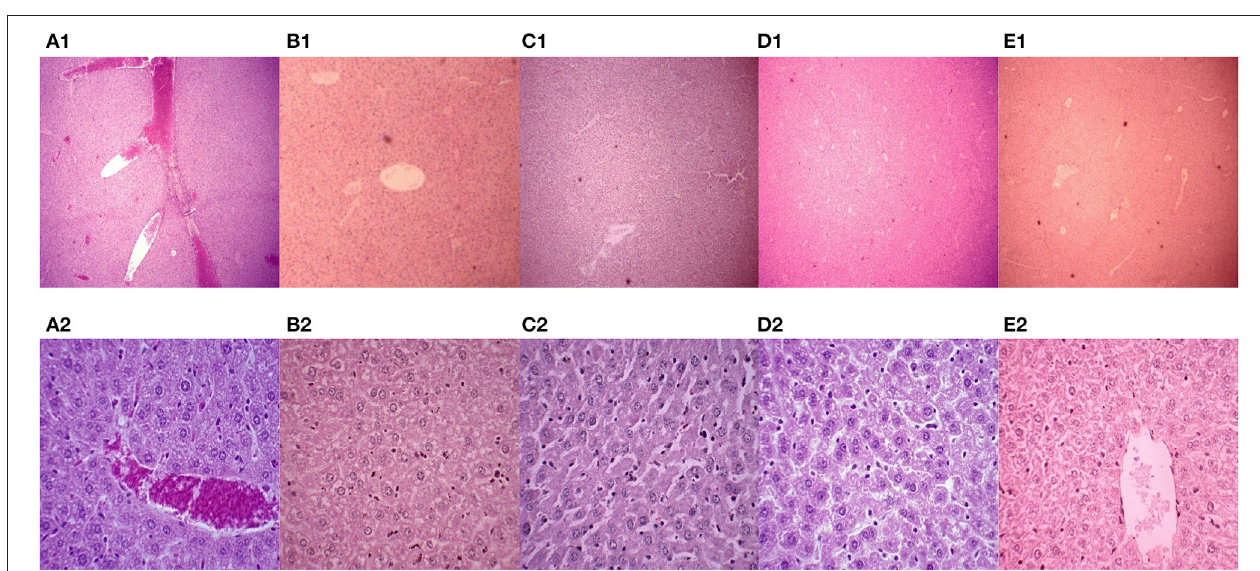
FIGURE 3 | Mouse liver pathology (H.E. 40 × ). (A1–E1) Mouse liver pathology (H.E. 40 × ); (A2-E2) Mouse liver pathology (H.E. 400 × ). (A) PBS control group. (B) vaccine 1 (43K OMP). (C) vaccine 2 (PL4 and H2). (D) vaccine 4 (killed whole cell F. necrophorum ). (E) vaccine 3 (43K OMP, PL4 and